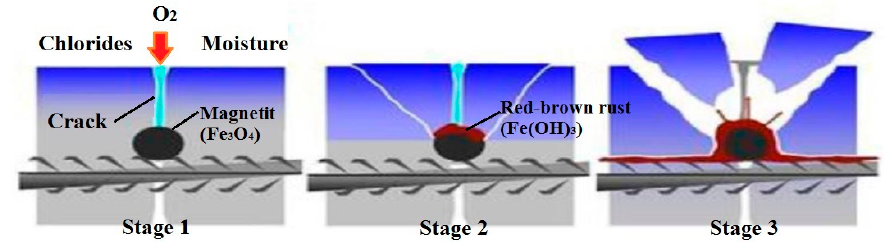
Figure 1. Process of aggressive solution penetration.